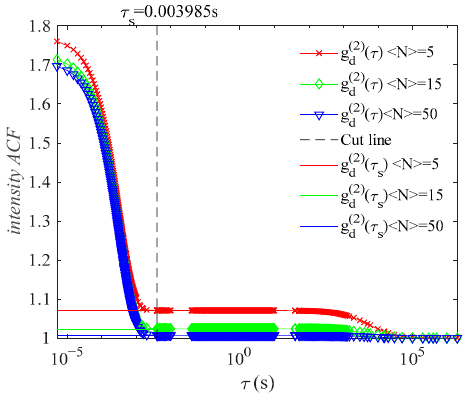
( 2 ) ( τ s ) of g ( 2 ) ( τ ) determined by τ s d d